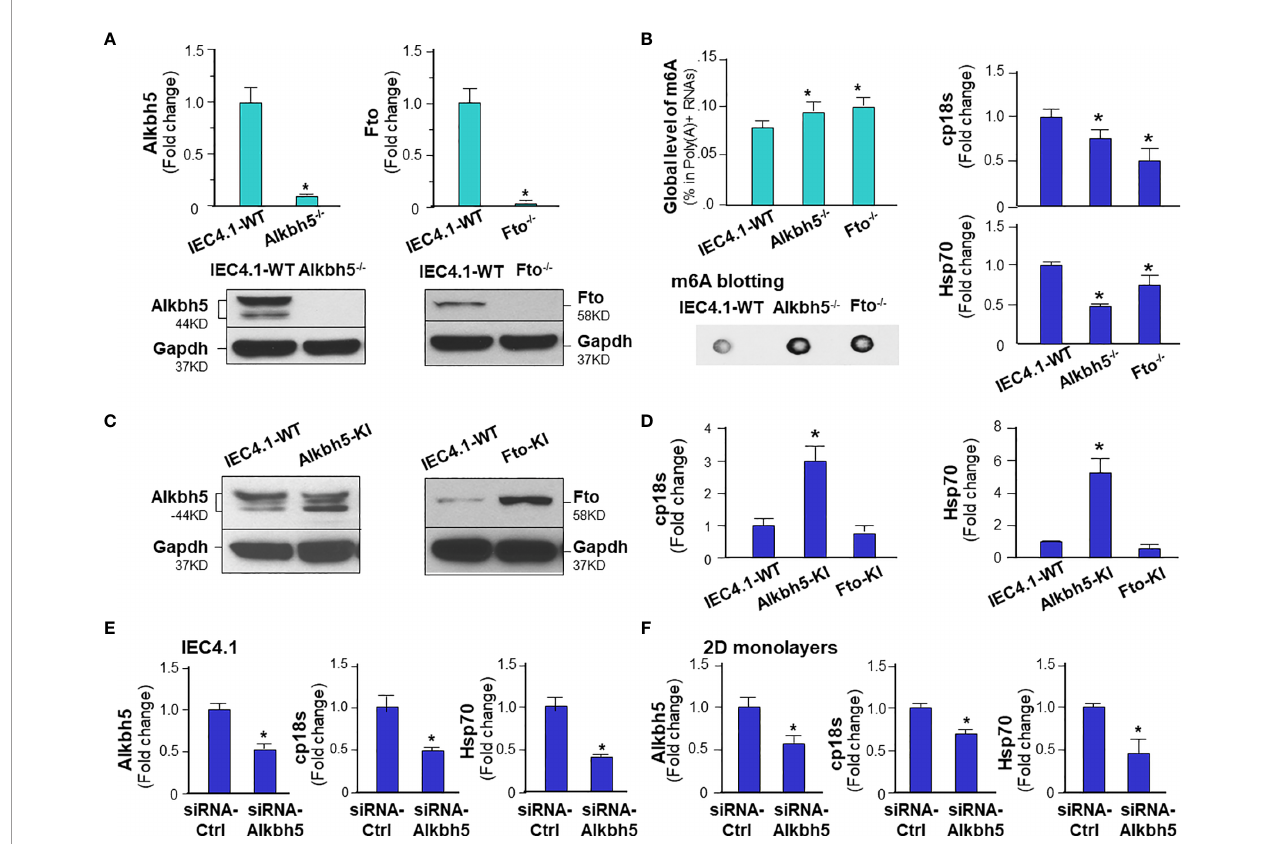
FIGURE 4 | m 6 A methylation modulates intestinal epithelial innate defense against C. parvum infection. (A) Knockdown of Alkbh5 or Fto in IEC4.1 cells. Cells were transfected with the CRISPR/Cas9 KO(h) for Alkbh5 or Fto and the HDR plasmids. Stable transfected cells were cloned and con fi rmed by real-time PCR and Western blot analysis. Gapdh was also blotted for control. (B) Knockdown of Alkbh5 or Fto in IEC4.1 cells decreased the infection burden of C. parvum infection. Knockdown of Alkbh5 or Fto increased m 6 A RNA methylation in IEC4.1 cells, as measured by m6A RNA methylation quantitation assay and dot blot. IEC4.1 cells and cells de fi cient with Alkbh5 or Fto were then exposed to C. parvum infection for 24 h. IEC4.1 cells transfected with the empty vector, marked as IEC4.1-WT (wild type) were used as the control. Infection burden of C. parvum was quanti fi ed by measuring parasite cpHsp70 or cp18s using real-time PCR. (C) Knock-in of Alkbh5 or Fto in IEC4.1 cells. Cells were transfected with the CRISPR/Cas9 KO(h) for active Alkbh5 (Alkbh5-KI) or Fto (Fto-KI) vectors. Stable transfected cells were cloned and con fi rmed by Western blot analysis. (D) Overexpression of Alkbh5, but not Fto, increased the infection burden of C. parvum in IEC4.1 cells. Cells stably expressing Alkbh5 or Fto were exposed to C. parvum infection for 24 h and infection burden of C. parvum was quanti fi ed. (E) Knockdown of Alkbh5 via siRNA decreased the infection burden of C. parvum in IEC4.1 cells. Cells were treated with the siRNA to Alkbh5 for 24 h and exposed to C. parvum infection for additional 24 h. Cells treated with the non-speci fi c scrambled siRNA were used as the control and infection burden of C. parvum was quanti fi ed. (F) Knockdown of Alkbh5 via siRNA decreased the infection burden of C. parvum in 2D intestinal epithelial monolayers. Monolayers were cultured and treated with the siRNA to Alkbh5 for 24 h and exposed to C. parvum infection for additional 24 h. Cells treated with the non-speci fi c scrambled siRNA were used as the control and infection burden of C. parvum was quanti fi ed. Data represent three independent experiments. *p<.05 vs cells transfected with the empty-vector control (as IEC4.1-WT in A, B, D ) or cells treated with the control-siRNA (in E, F